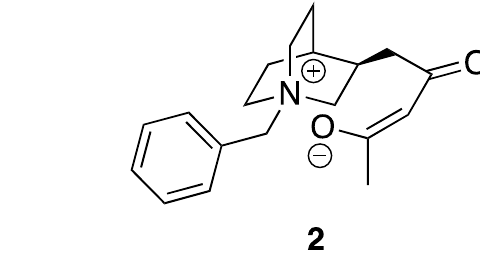
Figure 1. Probes ( 1 ) and ( 2 ) used in this